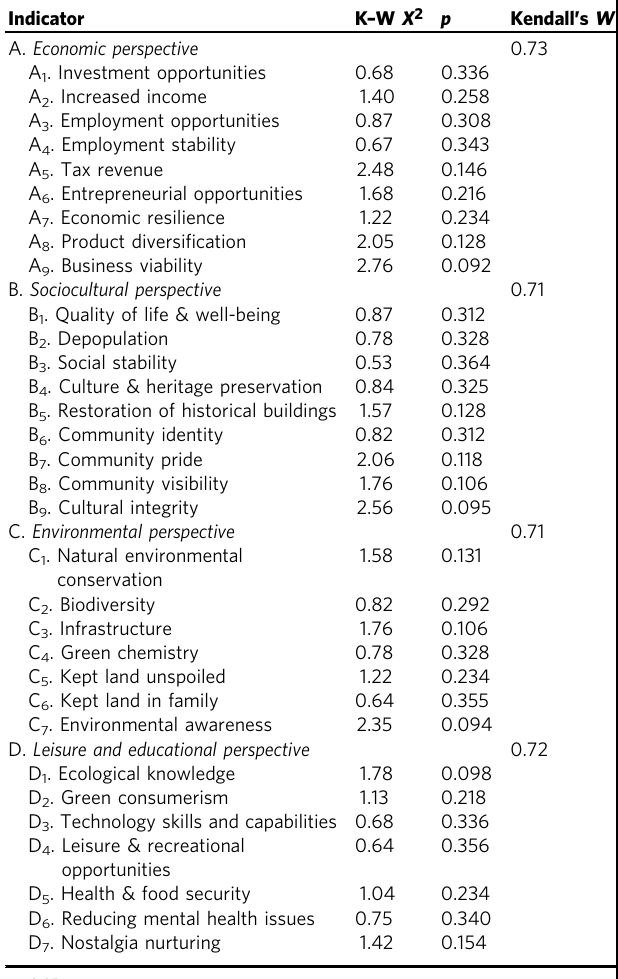
Table 2 Results of intergroup consistency and interexpert reliability